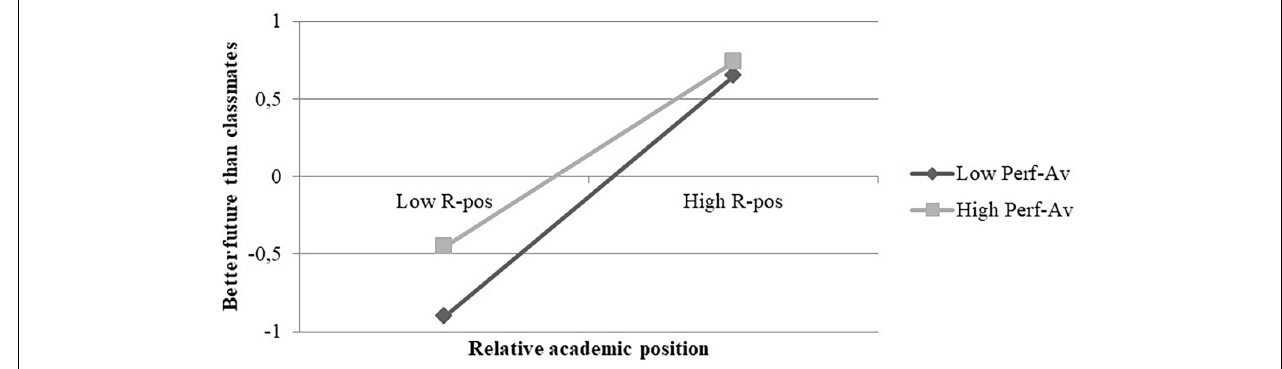
FIGURE 4 | Conditional effects of perceived relative academic position (R-Pos) on better future at different levels of performance-avoidance